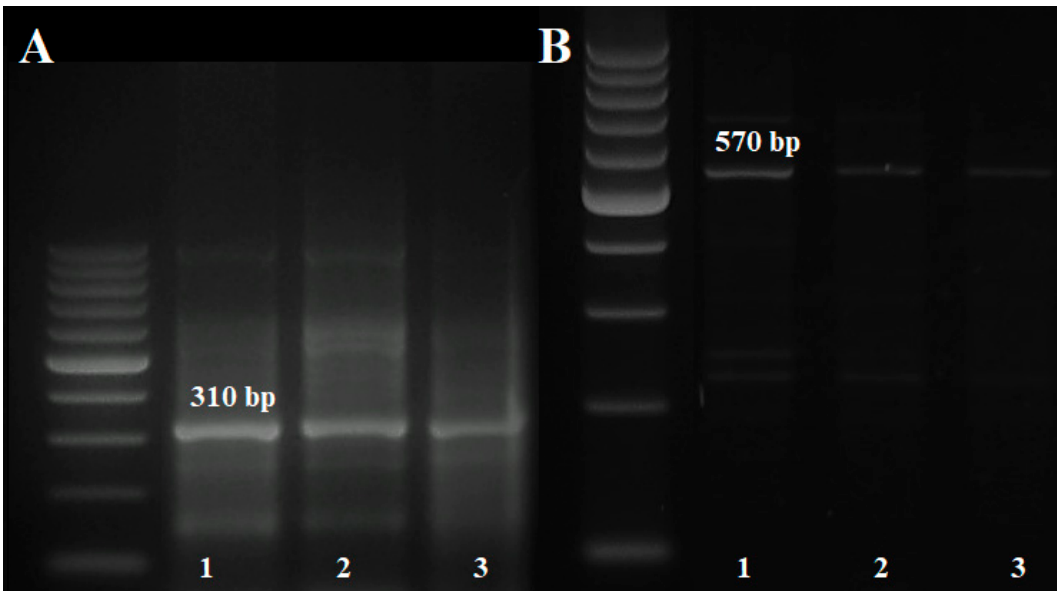
Figure 9. Identification of Lr gene markers in exemplary genotypes. Key: T—cv. Torka, Z—cv. Zebra,